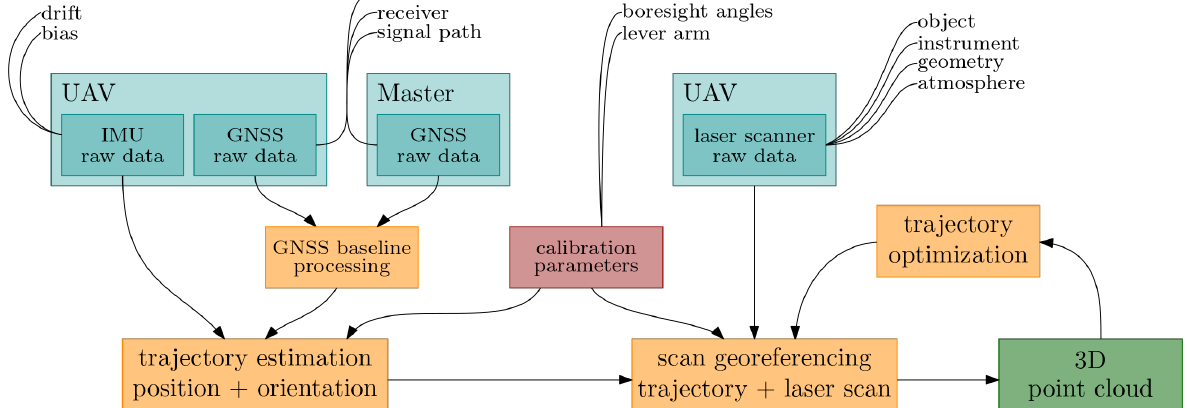
Figure 1. Processing of UAV-based laser scanning data with major error